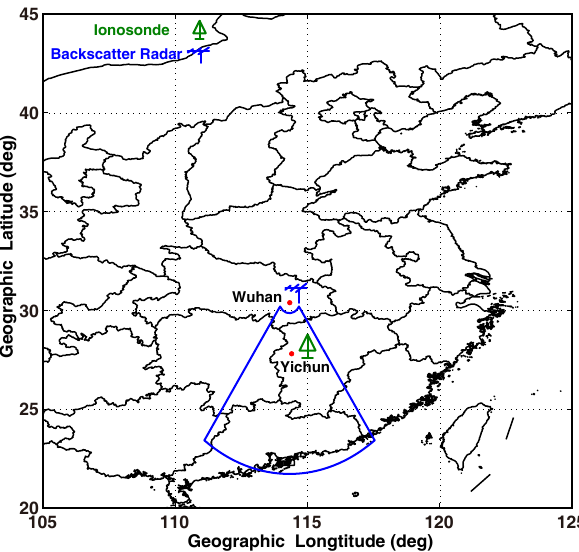
Fig. 2. Map showing the location of the WIOBSS at Wuhan and the location of the vertical ionosonde at Yichun for the experiment on 25 and 26 August 2010. The sector denotes the coverage of WIOBSS.